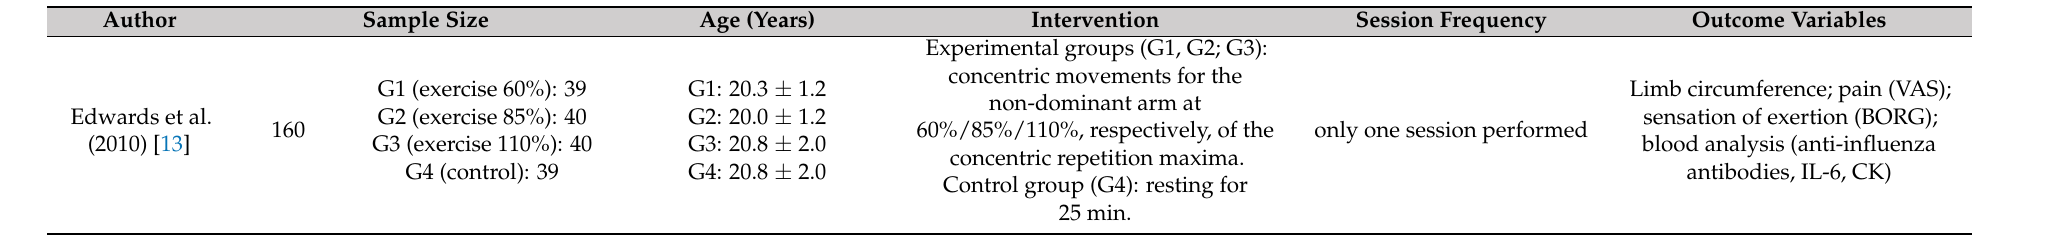
Table 2. Structural characteristics of the studies included in this systematic